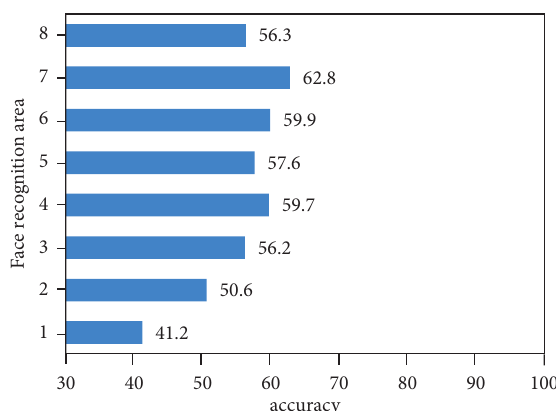
Figure 9: Recognition rate of microexpression images with different number of blocks.